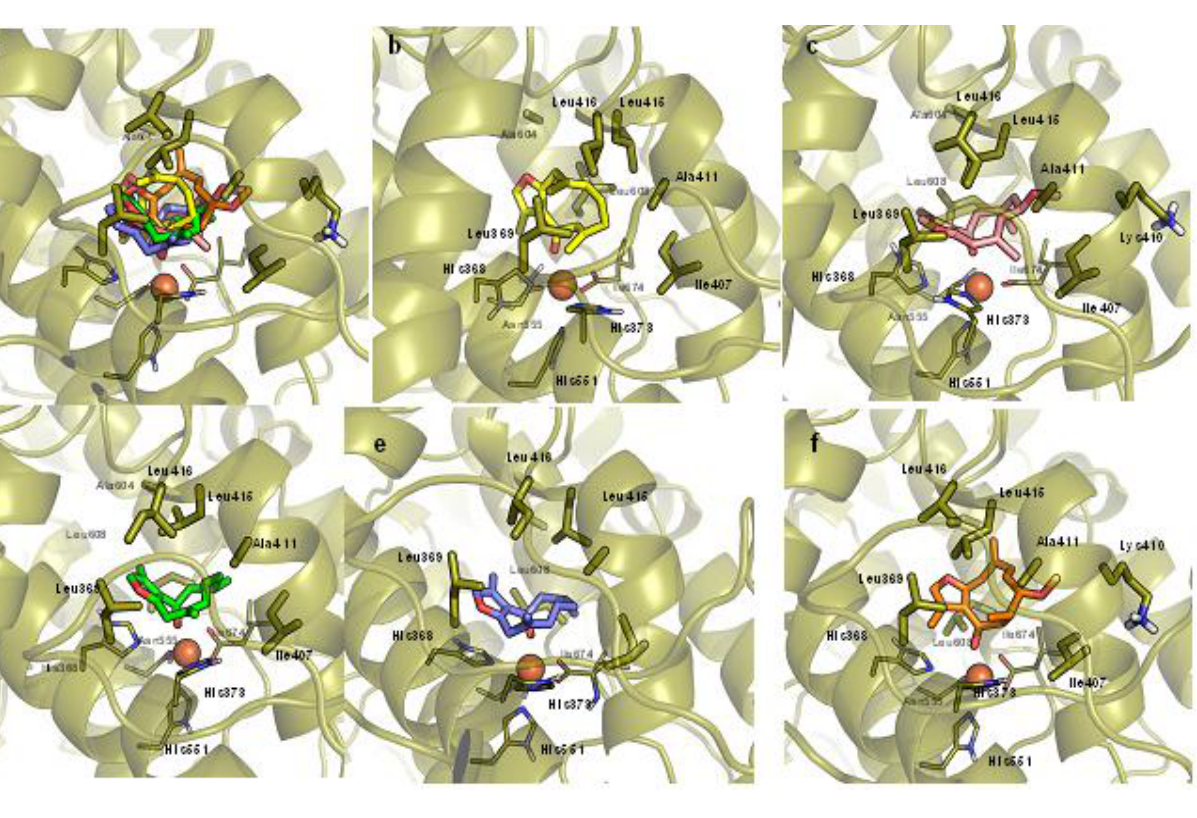
Figure 4. Selected binding poses of compounds 1 , 2 , 3 and 4 into the catalytic cleft of 5-LOX. Overlay of the compounds (a); compound 2 (b); compound 4 (c); compound S - 1 (d); compound R - 1 (e); compound 3